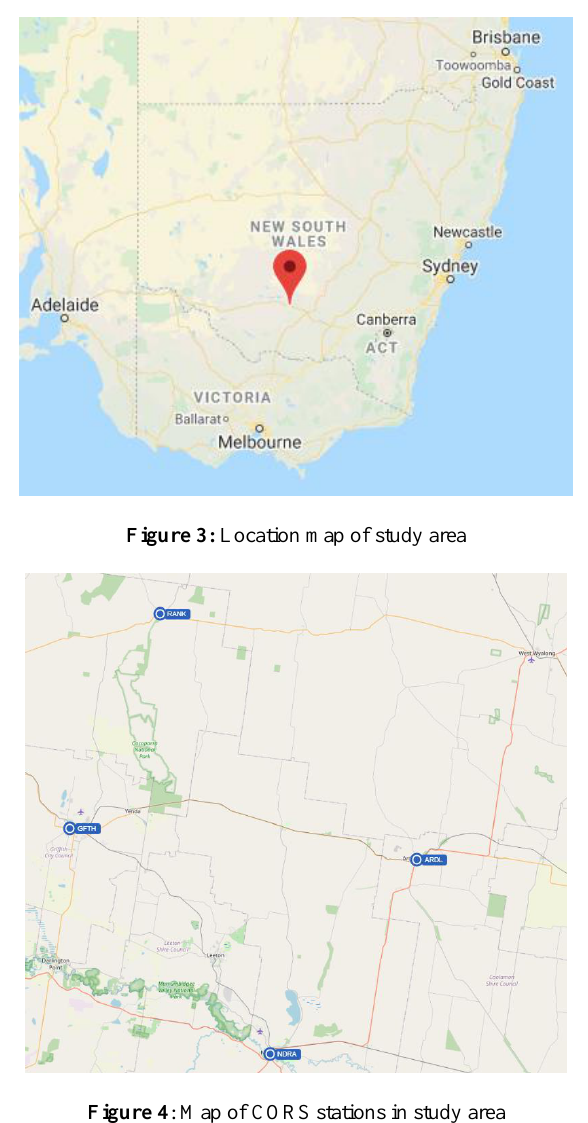
Figure 4 : Map of CORS stations in study area